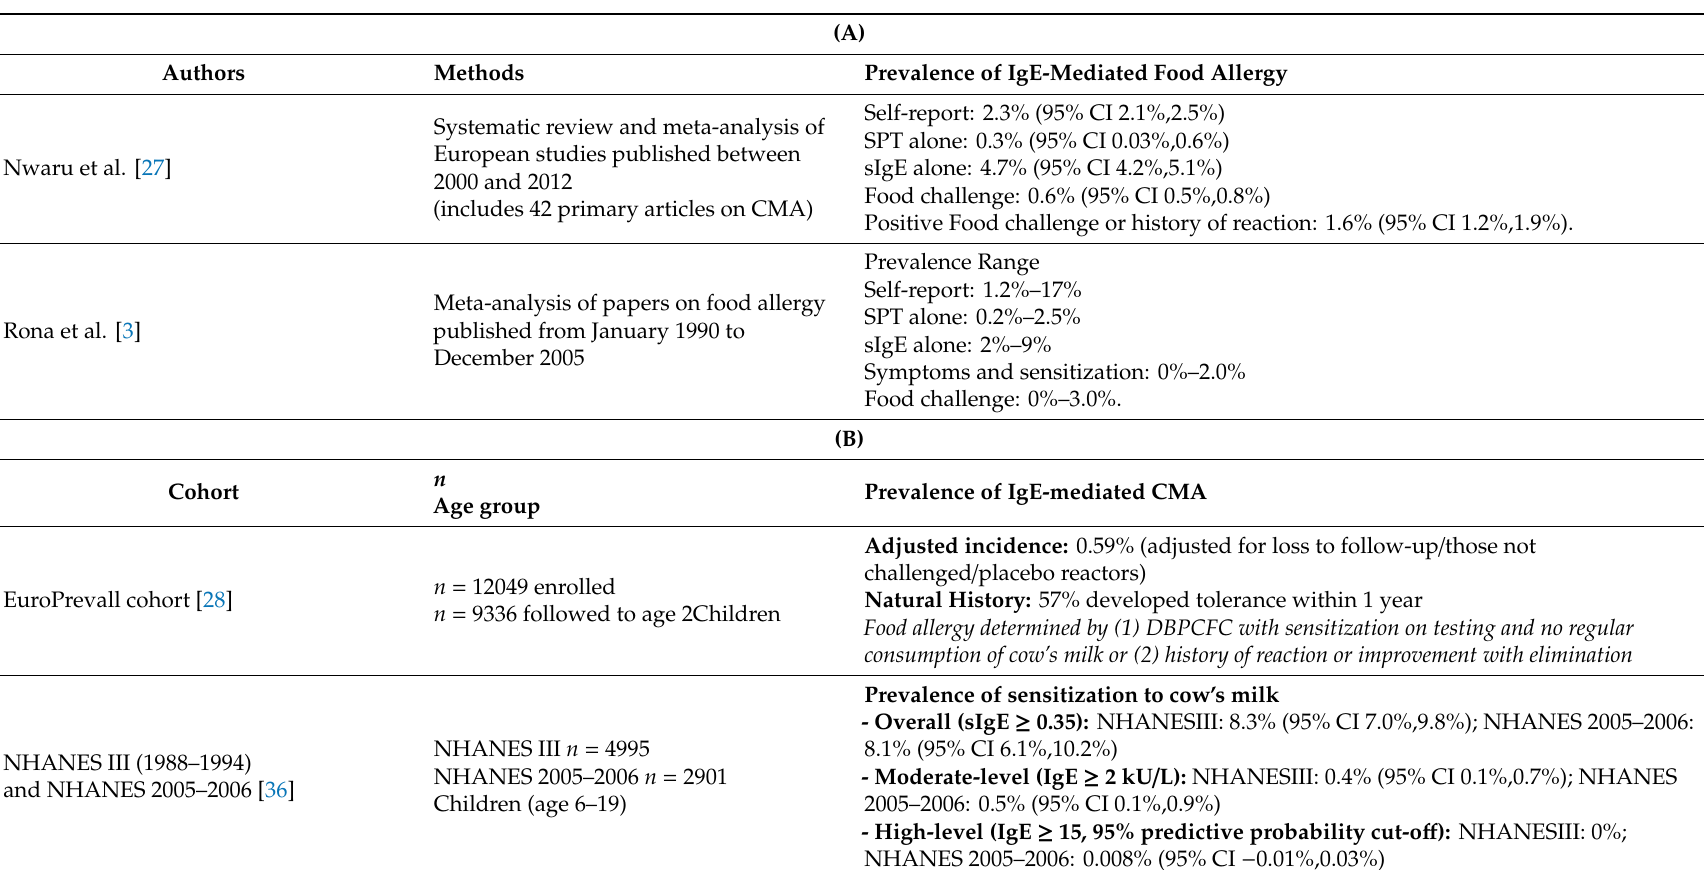
Table 2. (A) Estimates of prevalence from meta-analyses and individual studies. Meta-analyses. (B) Estimates of prevalence from meta-analyses and individual studies. Individual